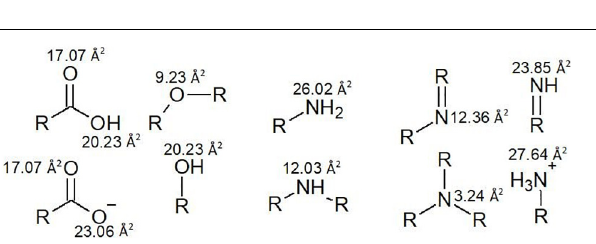
FIGURE 4 | Polar surface areas of the most common polar functional